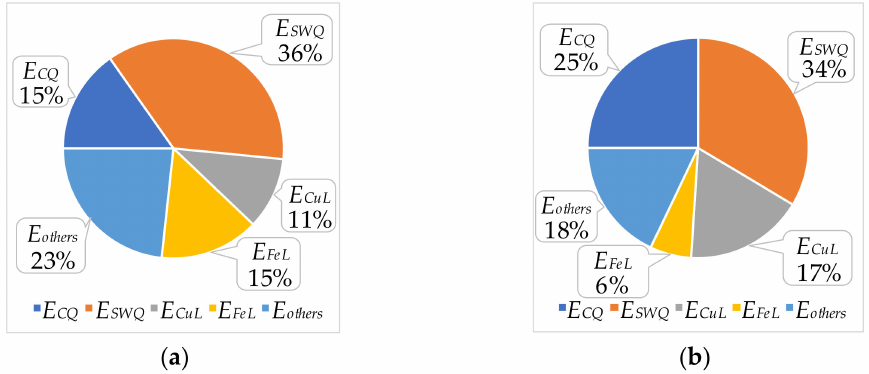
Figure 10. Loss distribution diagram of 4-pin all-SiC MOSFET PWM rectifier: ( a ) Half-load 15 kW ( E tot / P ≈ 2.0%), ( b ) Full-load 30 kW ( E tot / P ≈